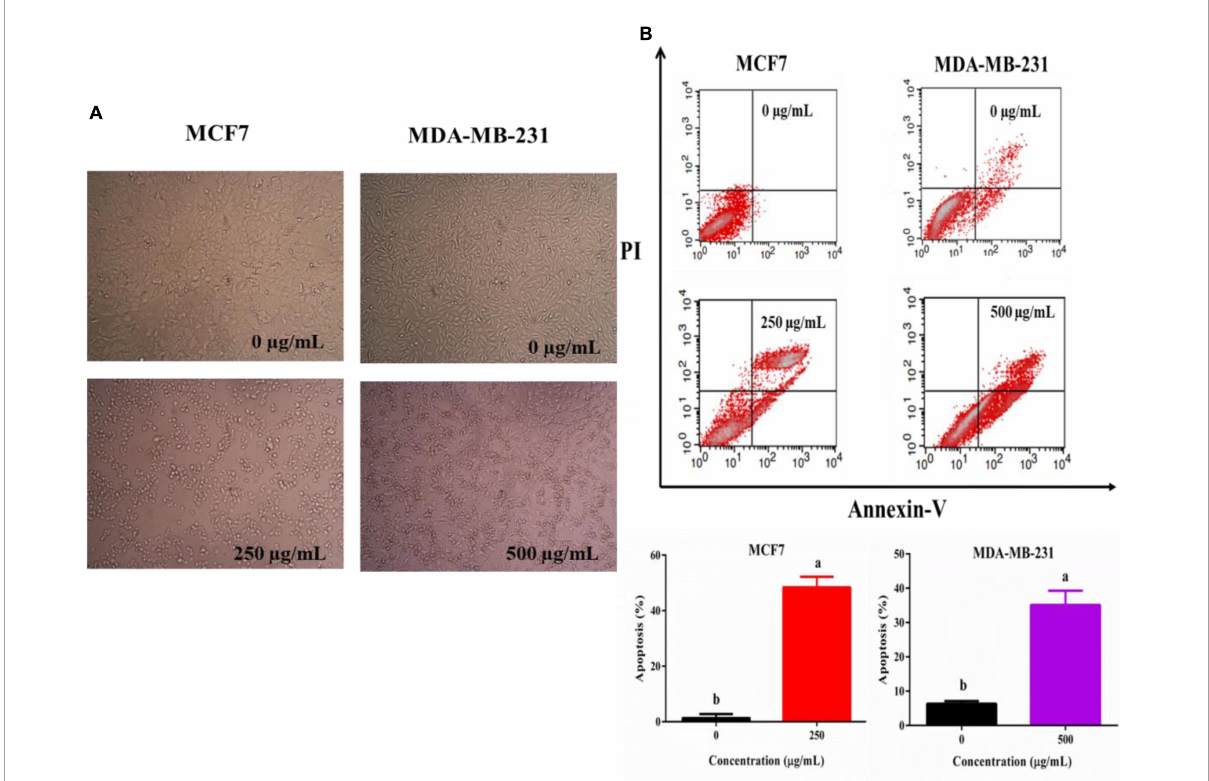
FIGURE7 TPVVVPPFL induced morphology alteration (A) and apoptosis of mammary carcinoma cells (B) . MCF7 and MDA-MB-231 cells were incubated with TPVVVPPFL for 48 h at the concentration of 250 and 500 ◦ µ g/mL, respectively. The image of the two cells was acquired by the inverted microscope, and the apoptotic cells were measured using a flow cytometry after treatment with Annexin-V and